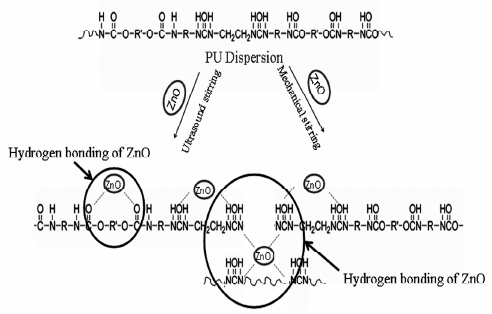
Table 3. Mixing of pristine ZnO along with other nano particle/metal oxide/polymer during PU/ZnO